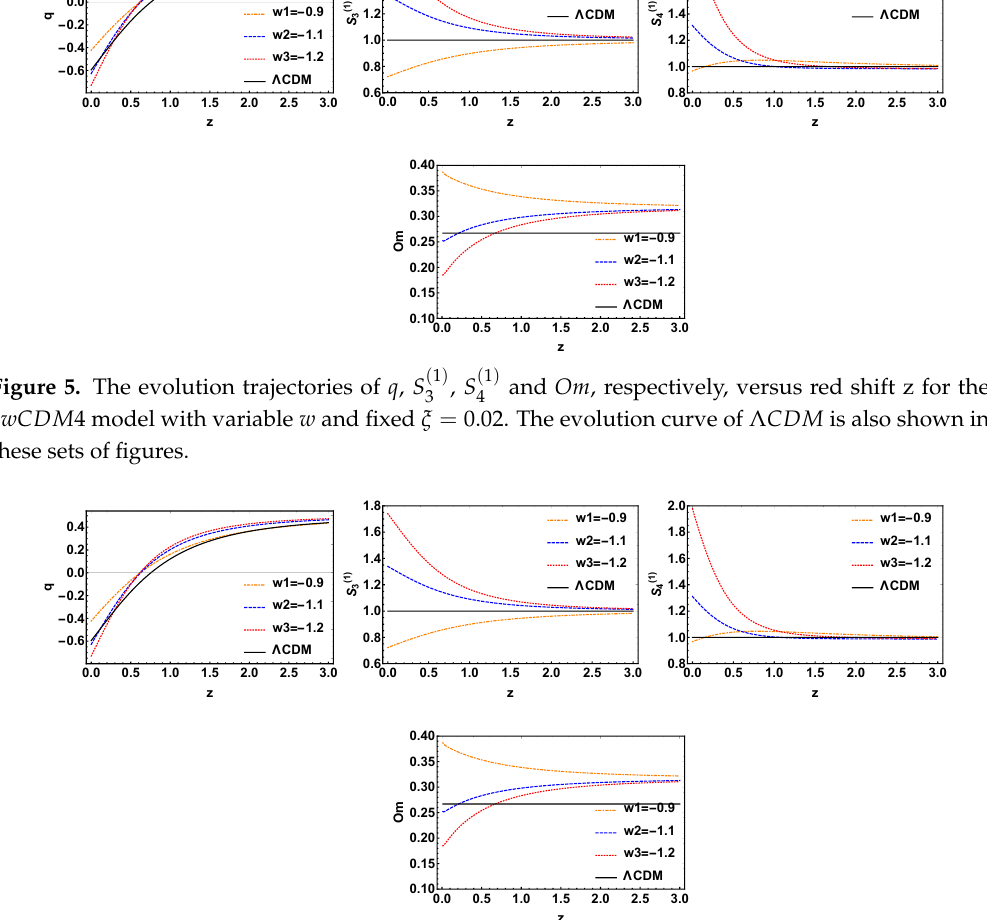
Figure 6. The evolution trajectories of q , S IwCDM 5 model with variable w and fixed ξ = 0.02. The evolution curve of Λ CDM is also shown in these sets of